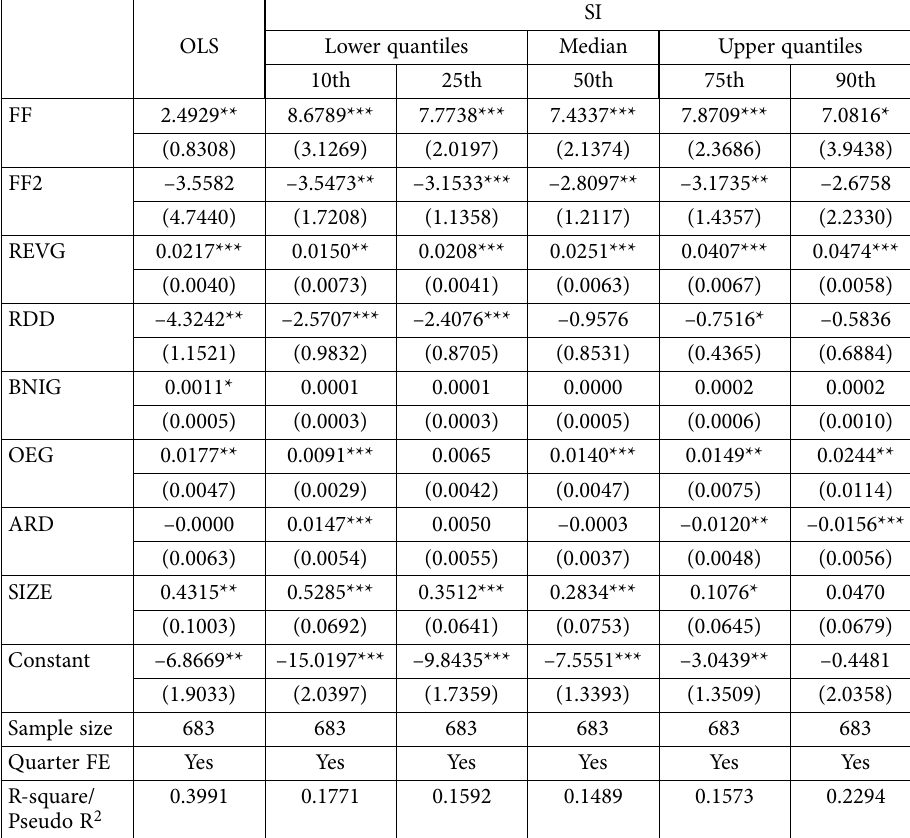
Table 14. OLS and QR results for the SI using FF-ind